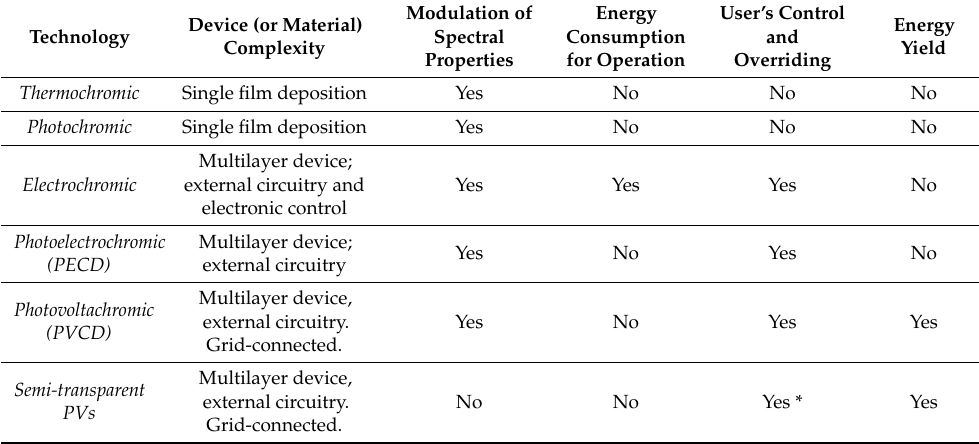
Table 1. Summary table, reporting a comparison of advantages and limits of several technologies available for building integration, including chromogenic and PV technologies (* only the PV operation can be overridden, without any e ff ect on optical properties of